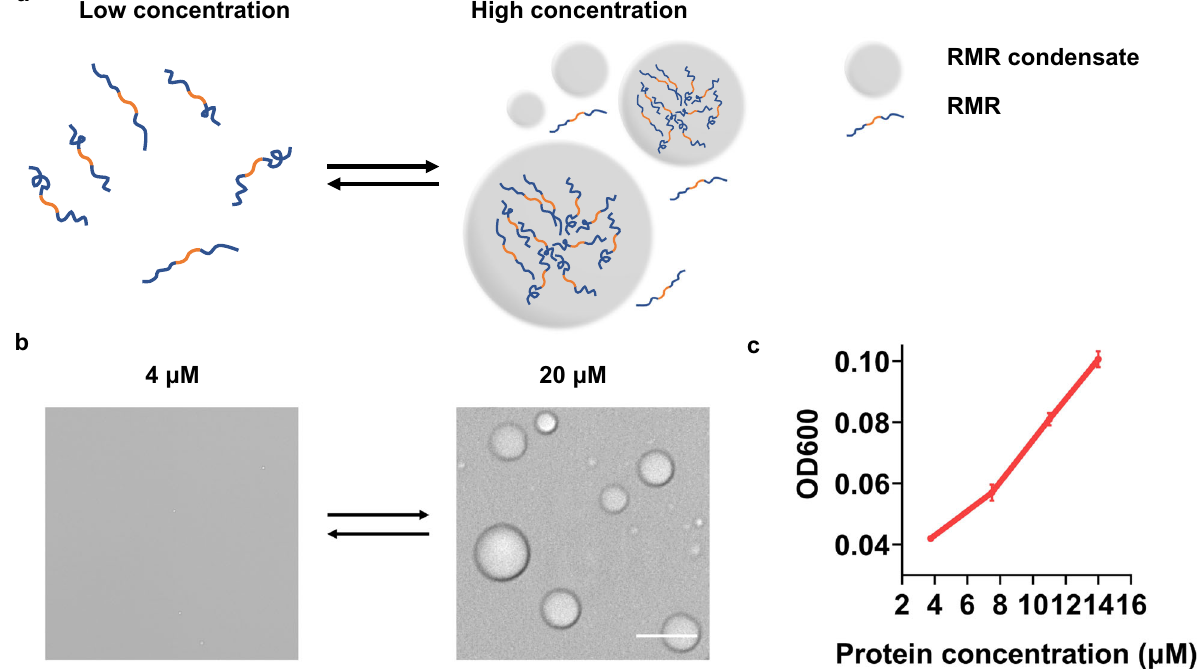
Fig. 2 Concentration-dependent liquid-liquid phase separation of RMR. a Schematic showing the phase separation of RMR. b Concentration-dependent phase separation of RMR at room temperature (23 °C). Scale bar: 5 μ m. Images representative of n = 3. c Optical densities at 600 nm at different RMR concentrations. The threshold RMR concentration for phase separation at 23 °C is 4 μ M. Data are presented as mean ± SD ( n =